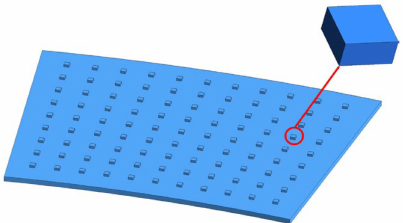
Figure 15. Schematic diagram of oil film with hexahedral texture.